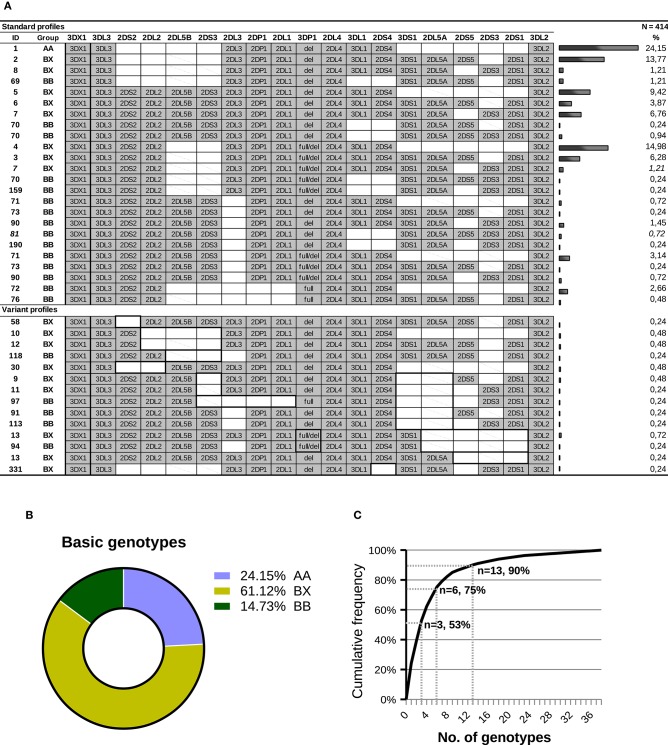
KIR-gene profiles observed in a sample of Spanish individuals. (A) Gene presence or absence is represented by solid gray and empty boxes; allelic forms are indicated for KIR3DP1. Carrier frequency is given on the right side of each genotype. Gene order reflects, approximately, that seen in the KIR complex, with genes forming A-haplotypes in the middle, flanked on both sides by genes characteristic of B-haplotypes. For KIR 2DL5 and 2DS3, genes represented by two paralogues, a diagonal line indicates that the gene is present in a genotype, but most likely in the alternative location. The ID column shows the number by which the genotype is registered in www.allelefrequencies.net (40); since this database does not distinguish between structural/positional variants, a same ID can correspond to several profiles in the table. Two profiles (7 and 81) include each one individual bearing a concealed variant haplotype, as explained in the text. In the lower part of the panel, which compiles gene profiles not explained by conventional haplotypes, thick lines highlight distinctive traits, including missing genes normally associated with ones present in a given genotype. (B) Distribution of the major groups of KIR genotypes. (C) Cumulative frequencies of KIR profiles.